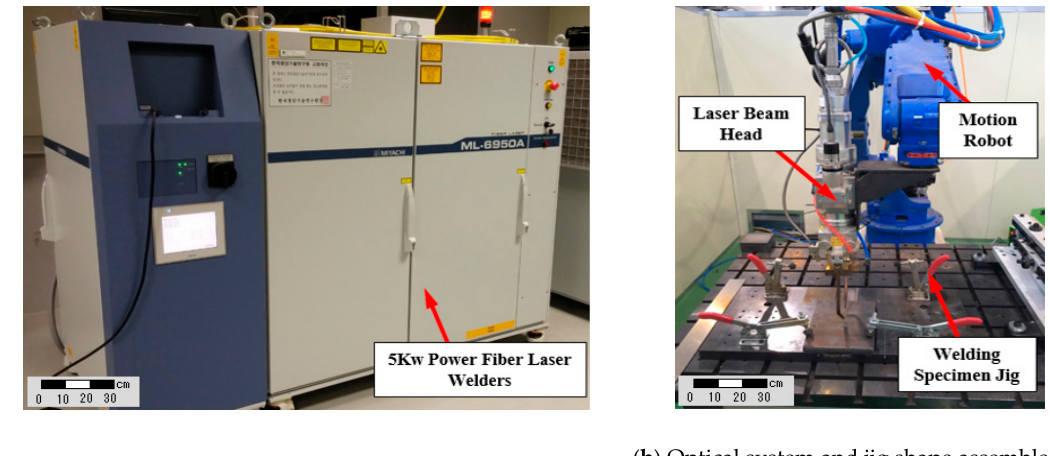
Figure 1. Experimental setup for fiber laser welding.